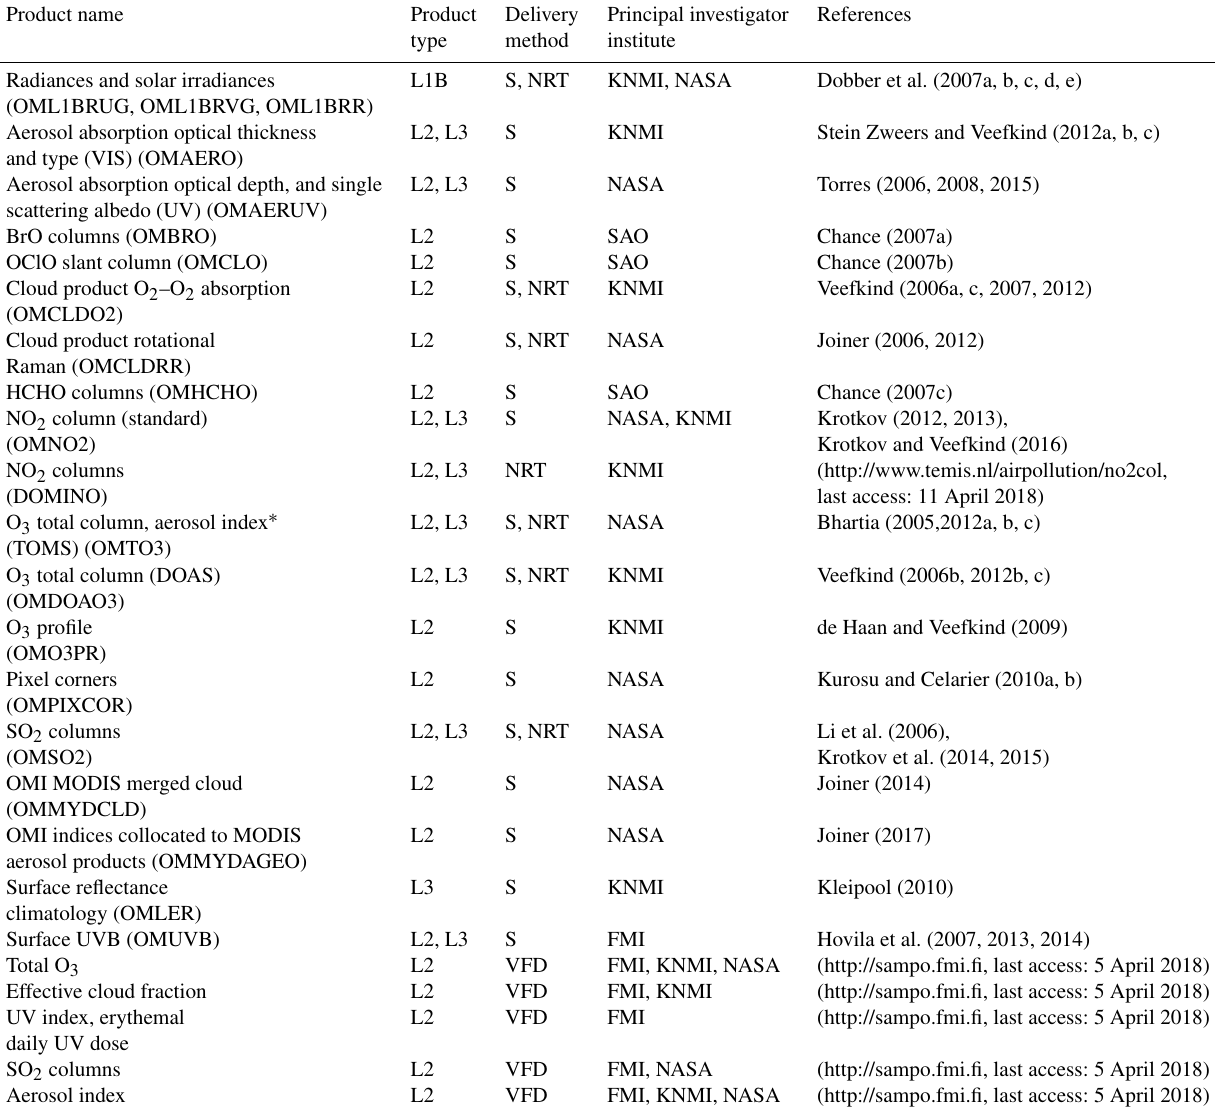
Table 1. OMI standard products along with their type (L1B: radiances and irradiances, L2: orbital data, L3: gridded data) delivery method (S: standard, NRT, or VFD), and principle investigator organization (the Royal Netherlands Meteorological Institute, KNMI; the Finnish Meteorological Institute, FMI; National Aeronautics and Space Administration, NASA; and the Smithsonian Astrophysical Observatory,